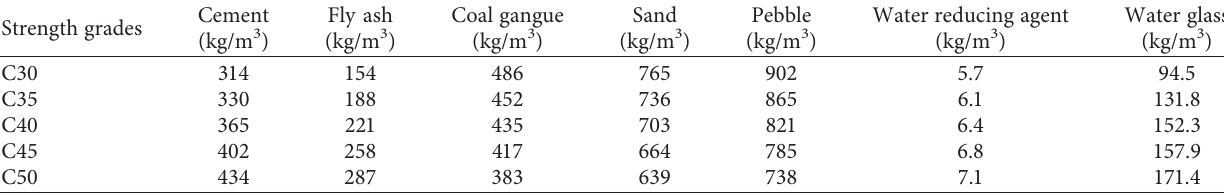
Table 4: Mix design of different strength grades coal gangue-based geopolymer concrete (before optimization).